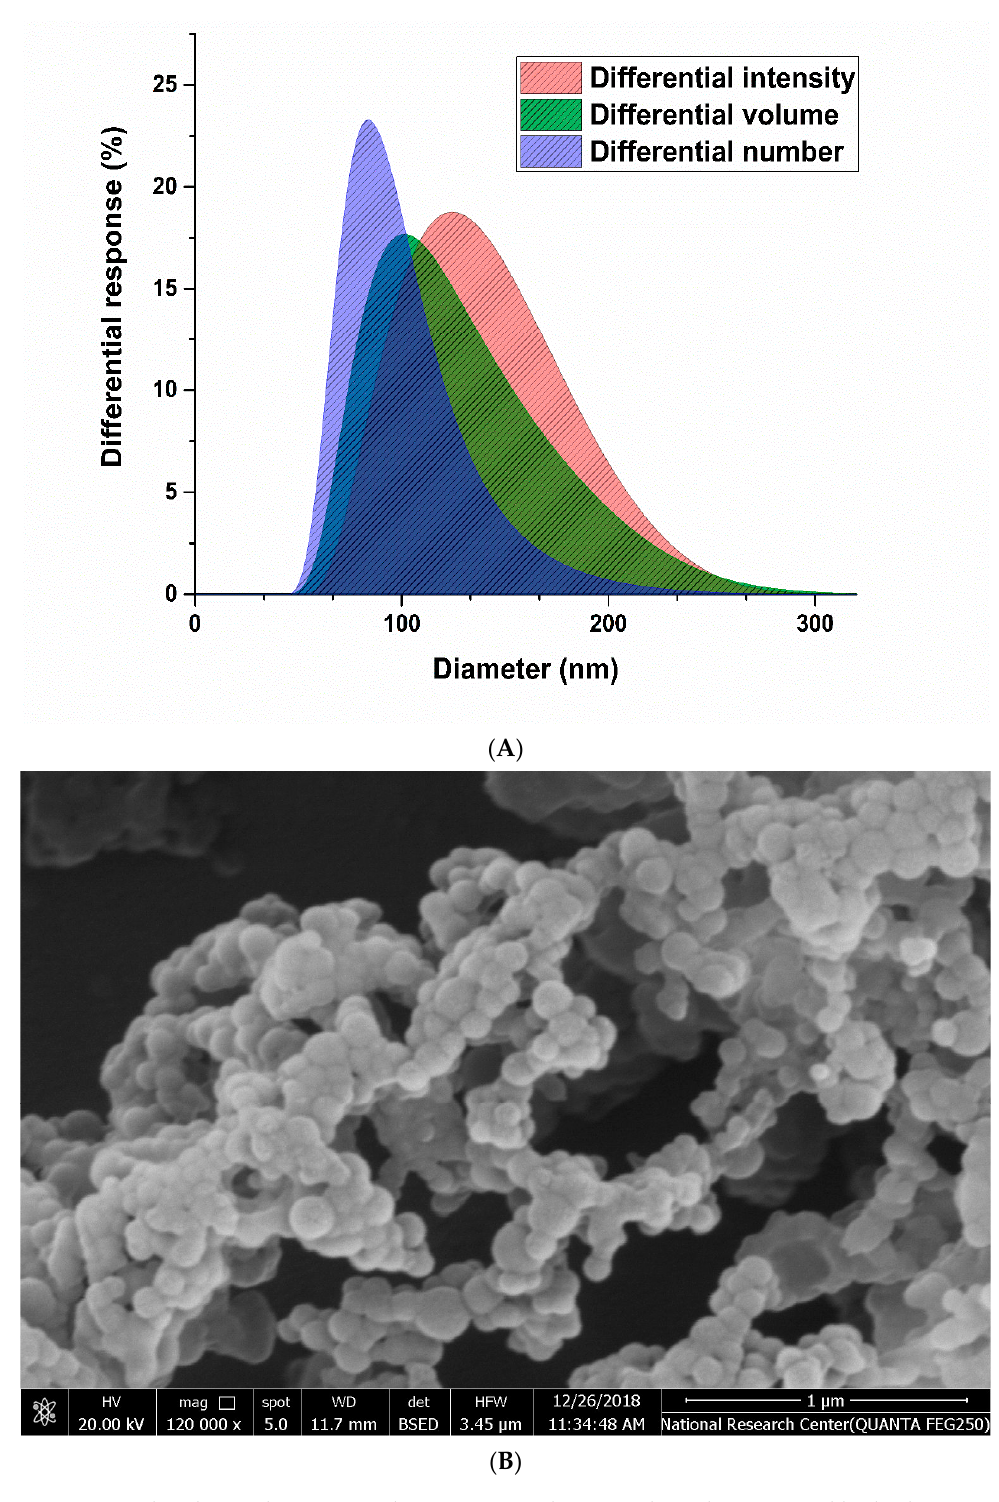
Figure 1. Size distribution histograms, the intensity-, volume-, and number-averaged hydrodynamic diameter histograms of a selected SML-ANPs ( A ), scanning electron micrograph ( B ).